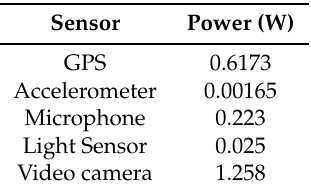
Table 2. Sensor power consumption [44,45].